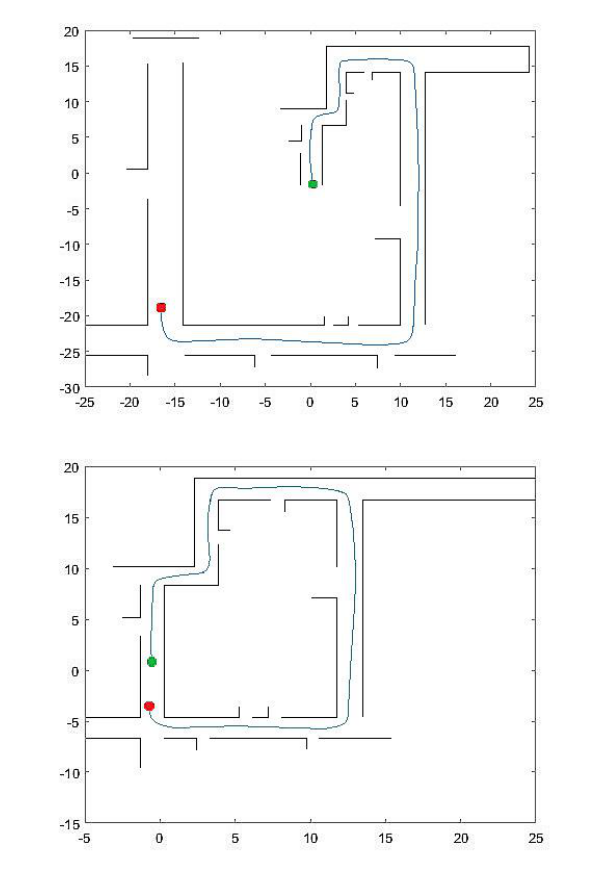
Figure 7. Generated layout top view for first loop (unit meter). Top: estimated layout with no loop closing. Bottom: adjusted layout through loop